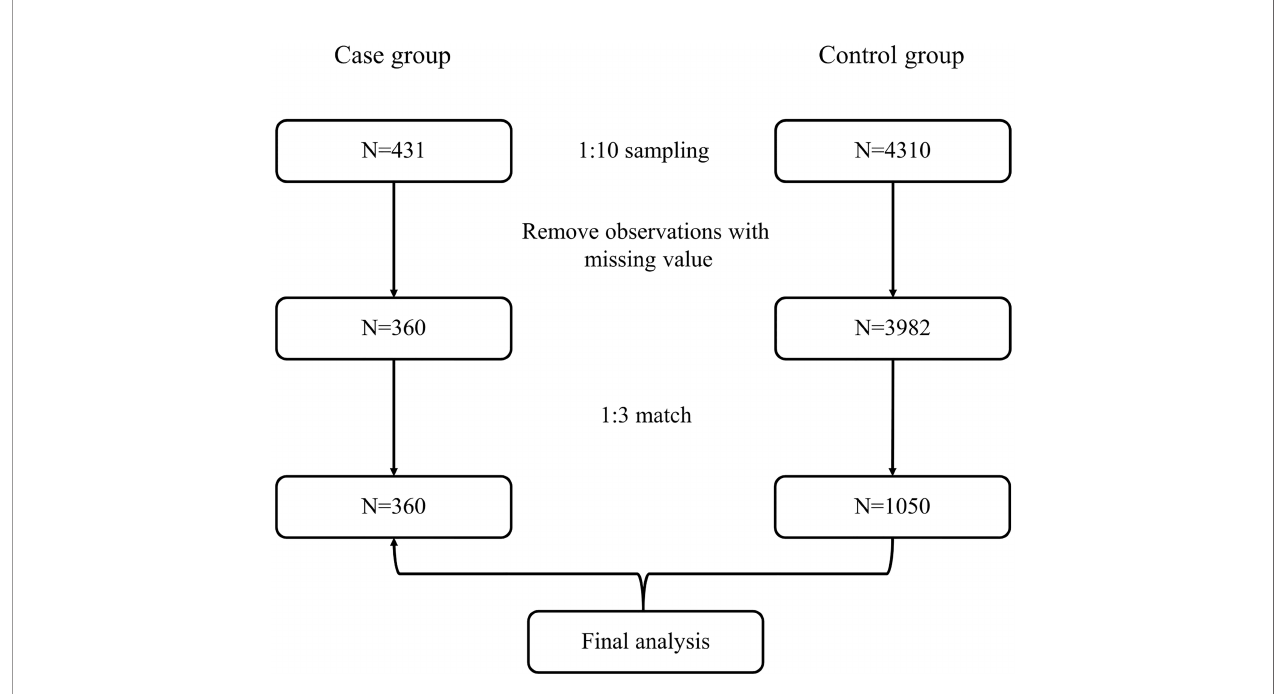
FIGURE 1 | Flowchart of the selection of